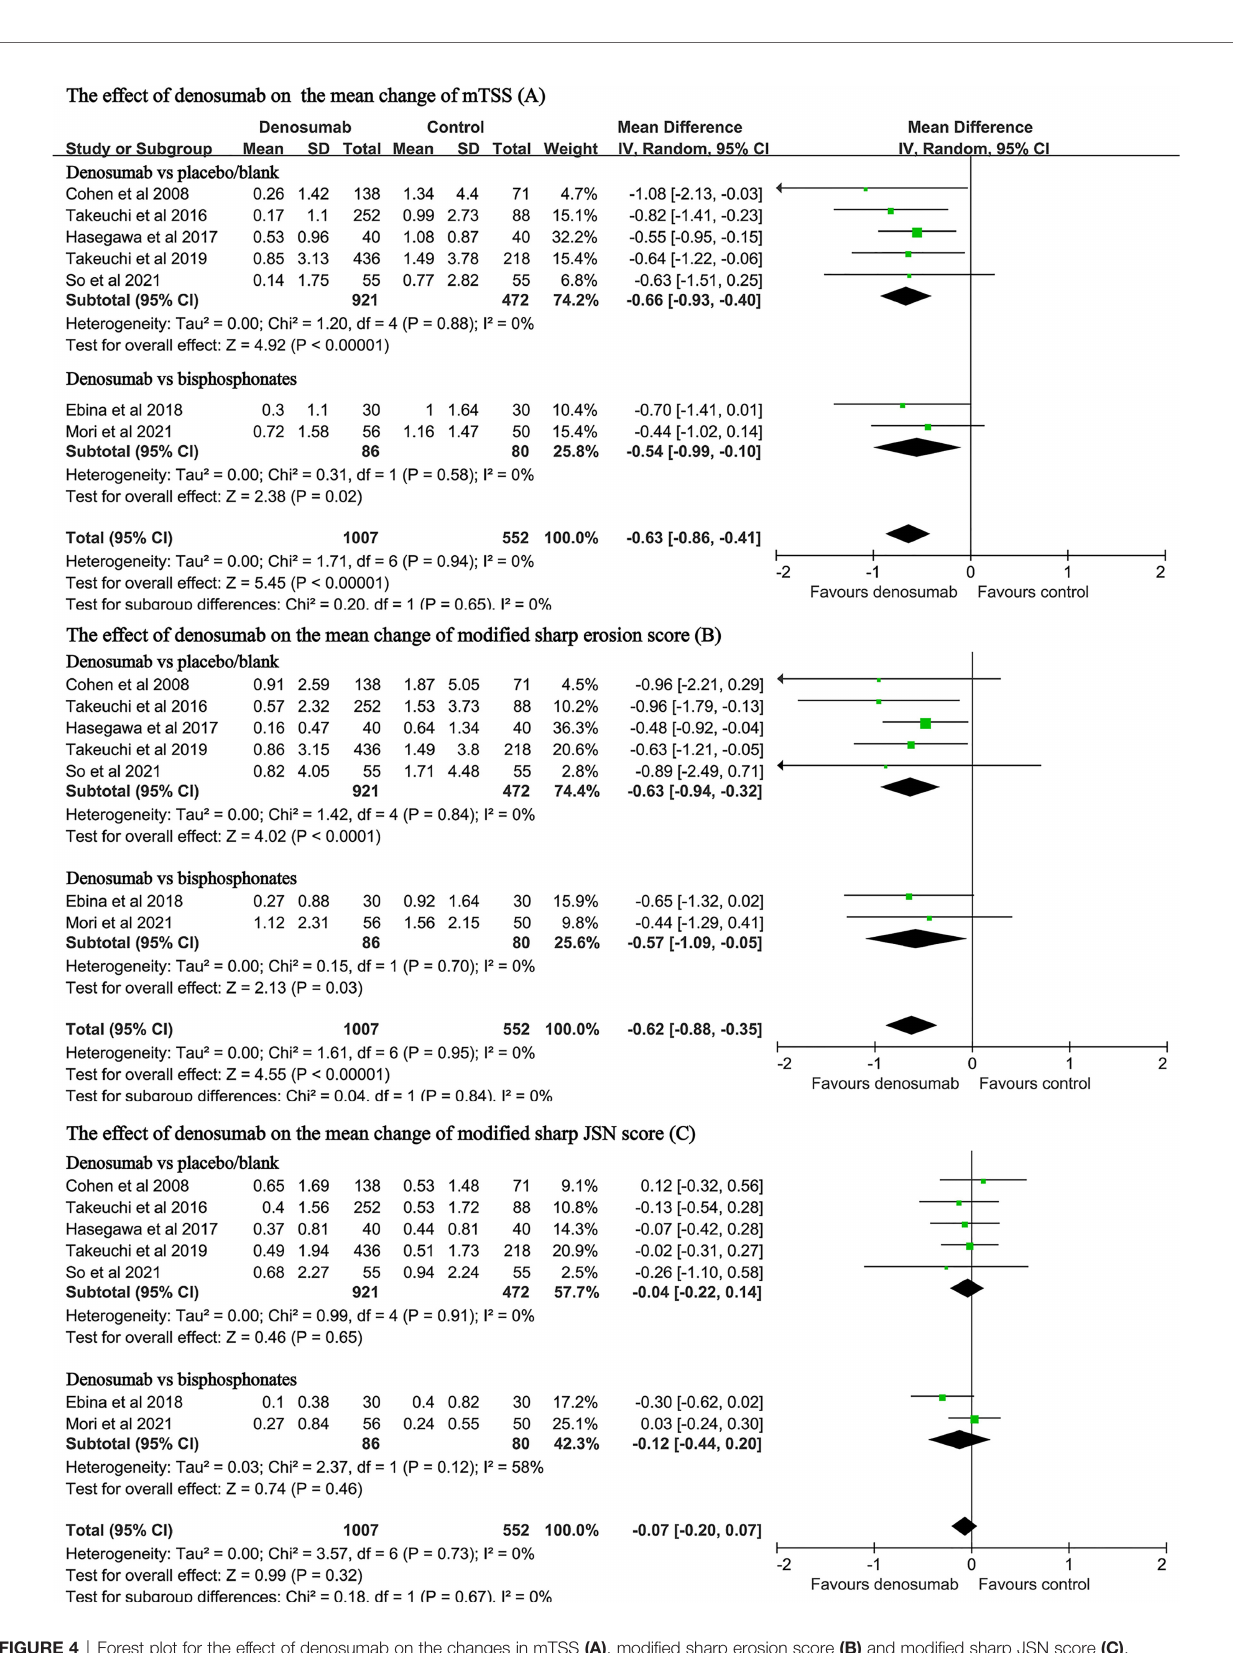
Frontiers in Immunology |